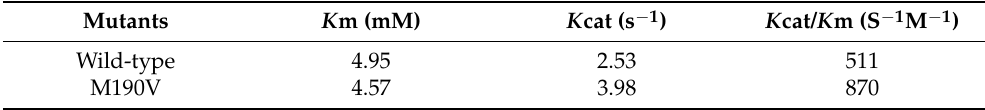
Table 1. Apparent kinetic parameters of the wild-type and the mutant M190V.